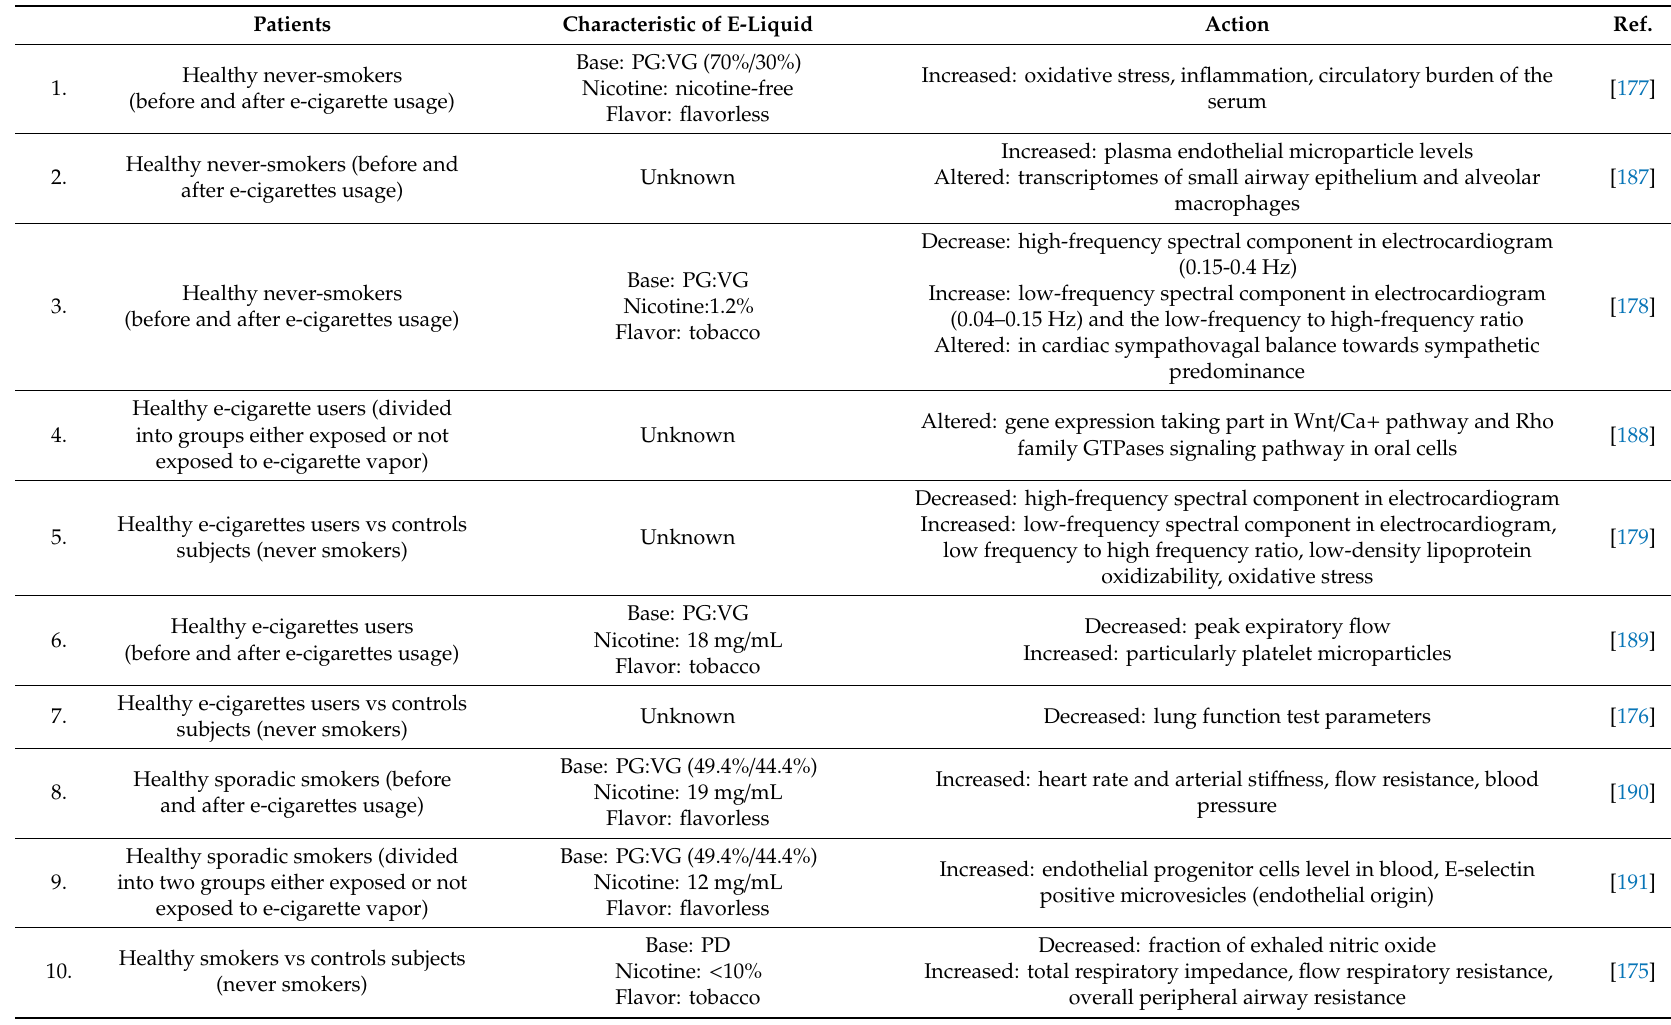
Table 3. The impact of e-cigarette liquid exposure on e-cigarette users (in vivo